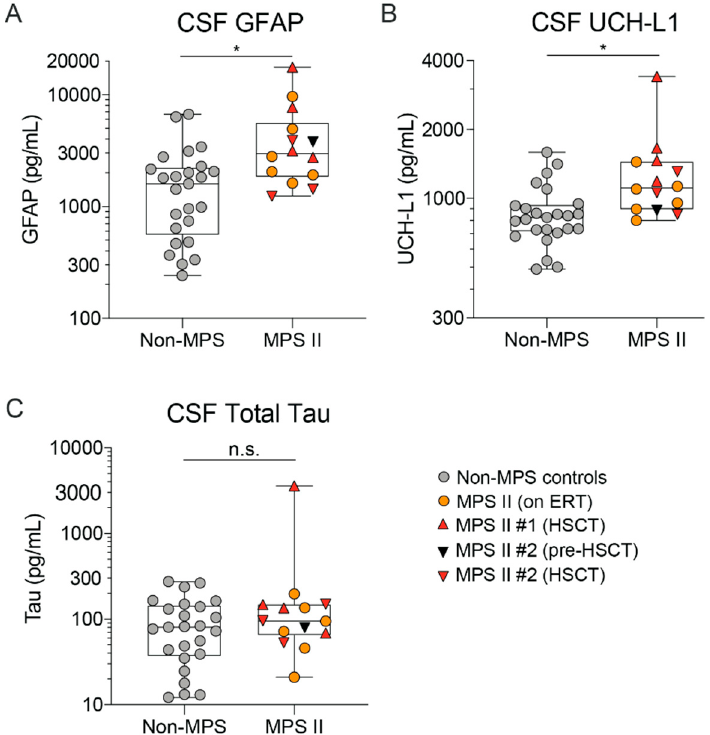
Figure 9. Neurodegeneration markers GFAP and UCH-L1 are elevated in nMPS II CSF. ( A ) GFAP, ( B ) UCLH-L1, and ( C ) total-Tau were quantified using SIMOA detection. nMPS II patients who were either untreated at the time of sample collection ( n = 1), on enzyme replacement therapy ( n = 6), or on HSCT ( n = 2) were compared to age-matched controls ( n = 25). Each data point represents a single control or patient visit. Data are plotted using a min to max box plot. Differences between nMPS II and non-MPS controls are estimated using a linear-mixed effects model to account for repeated measures in 2 patients. No evidence of age or treatment is seen in the MPS II sample set, and thus the model will not specifically adjust for these in the estimation; n.s.- not significant; * p < 0.05.